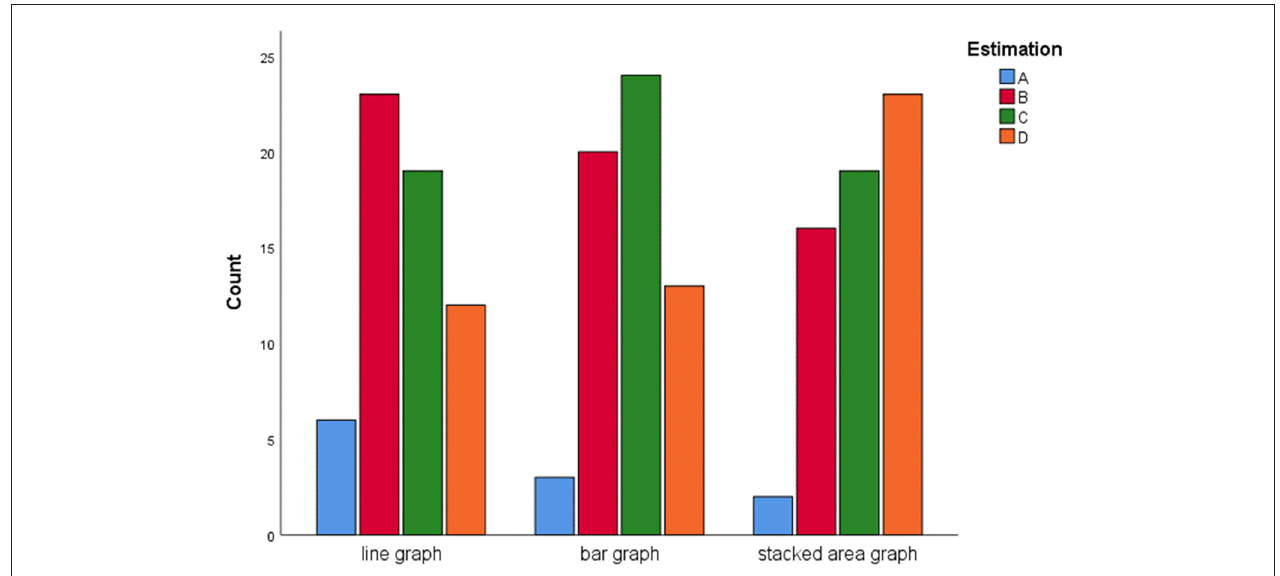
FIGURE 7 | Estimation counts of the new cases on Jun 30,